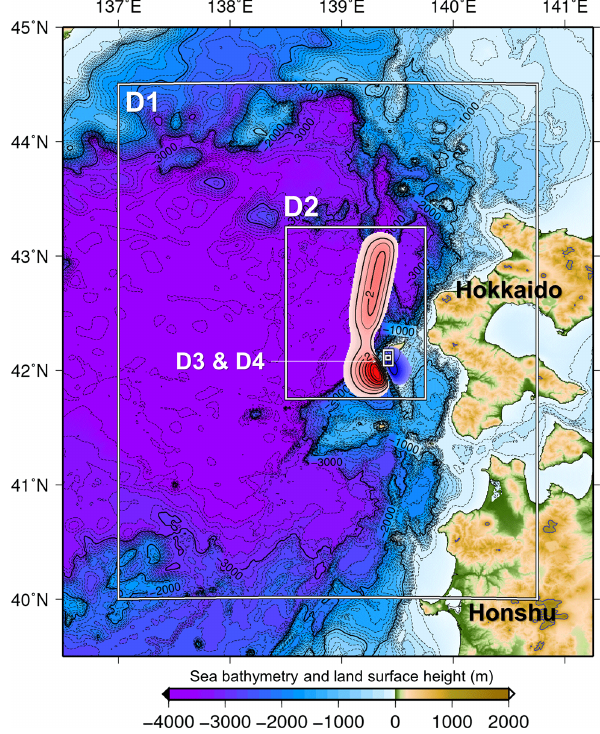
Figure 2. Domains for the tsunami model experiments following the 1993 Hokkaido–Nansei–Oki earthquake and location of tsunami initial conditions. Subdomains D1, D2 and D3 are for the H-model, while the subdomain D4 is for the